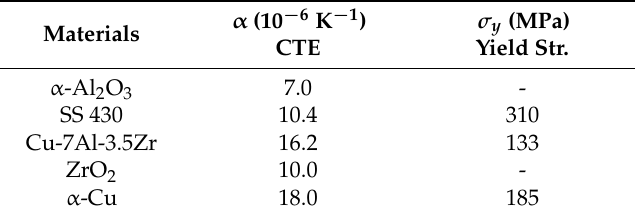
Figure 11. Magnified high-angle annular dark-field (HAADF) image of deflected area X in Figure 7 for the joint brazed at 980 °C for 0 min. Table 2. Thermal and mechanical properties of the materials used in the simulations (at 25 °C).